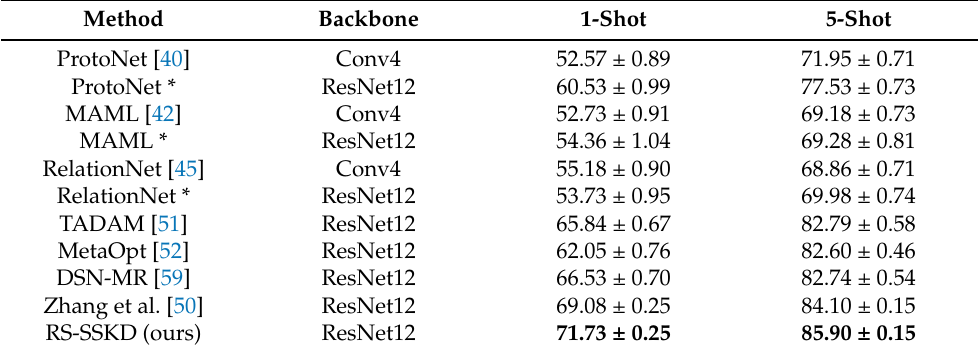
Table 3. Comparison to prior works on RSD46-WHU. Average 5-way accuracy (%) is reported with 95% confidence interval. * represents the backbone of the original method is replaced with Resnet-12. Values in bold indicate the ones with the highest classification